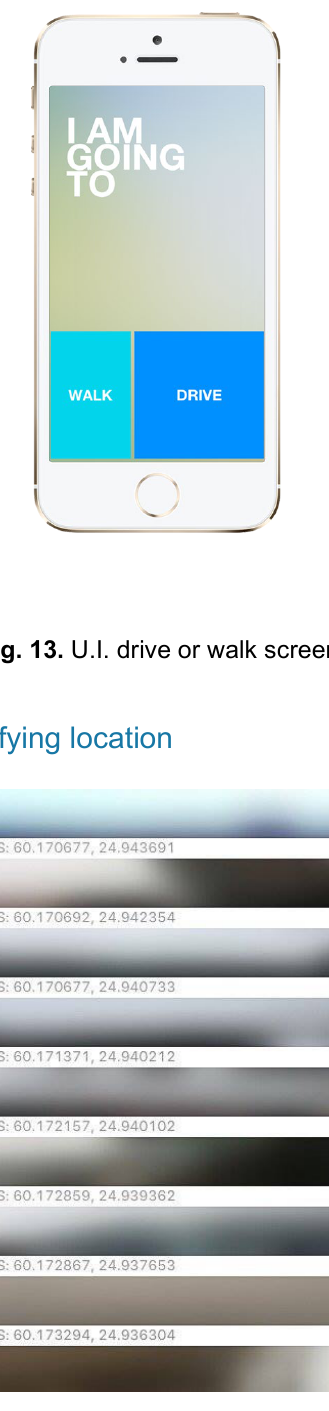
Fig. 14. GPS default graphic aspect – CitySkin